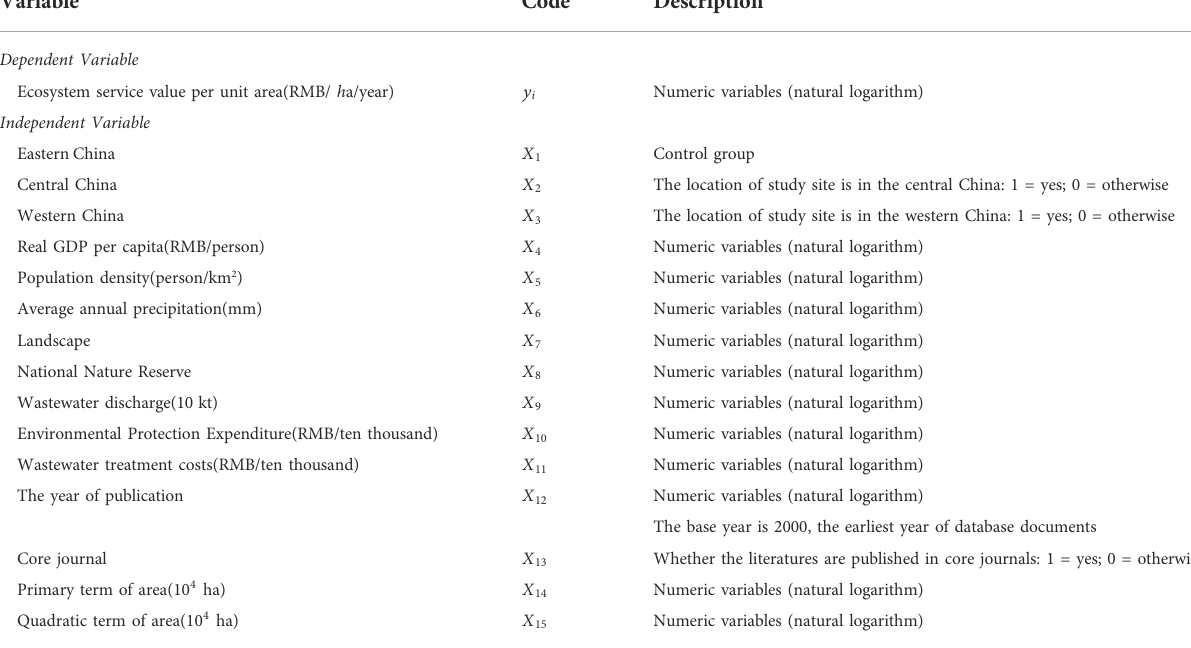
TABLE 2 Explanation of variables in Meta-regression